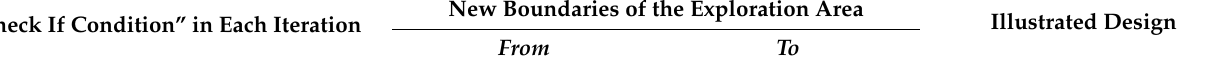
Table 2. The second condition that checked by the ICSA to update the exploration area. In the second condition, the reference power value is neither the highest nor the low- est power values in that iteration. In this case, the proposed algorithm promotes the area between the reference power value and the highest power value for the next search oper- ation, as described in Table 2.